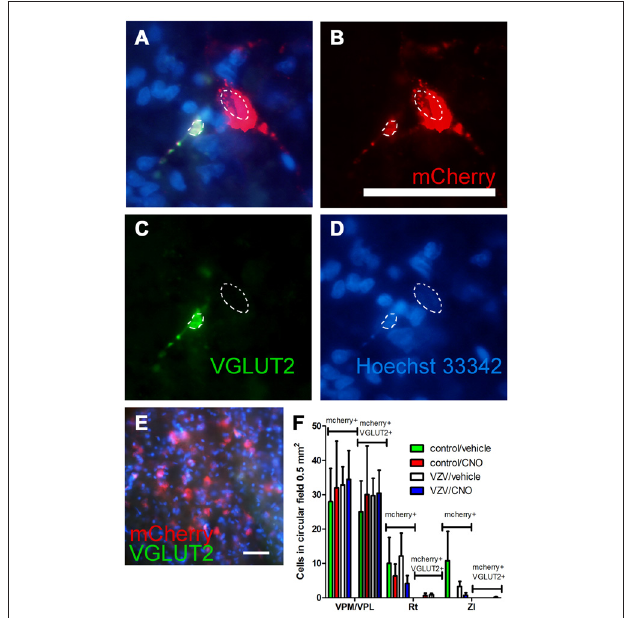
FIGURE 6 | Experiment 3, (A–D) immunofluorescent staining of the VPM/VPL thalamus of a rat 4 weeks after infusion of AAV8-hSyn-hM4D(Gi)-mCherry (red). Two nuclei are outlined with a dashed line. Vesicular glutamate transporter 2 (VGLUT2) is a marker of glutamatergic excitatory neurons. Immunostaining of the brain section indicated VGLUT2 (green) and the neuron silencer virus AAV8 (red) were co-expressed in some cells ( A , yellow). In (A–D) the representative animal was injected with control (MeWo) cells and given an IP injection of vehicle (0.5% saline). (E) shows a coronal brain slice after staining with secondary antibody but omitting the VGLUT2 antibody. Nuclei were stained blue with Hoechst 33342. Bar equals 50 micrometers. (F) AAV8 infected (mCherry+, see bracket) and mCherry+ cells that co-localize with VGLUT2 (mCherry+ and VGLUT2+, see bracket) were counted in circular fields 0.5 mm 2 in area. Counts were completed in randomly chosen fields adjacent to the injection site in several thalamic regions; the VPM, VPL and reticular (Rt) thalamic nuclei, as well as the ZI. n = 3 for the control/vehicle and control/CNO groups and n = 4 for the VZV/vehicle and VZV/CNO groups. Values on the histogram are the mean and